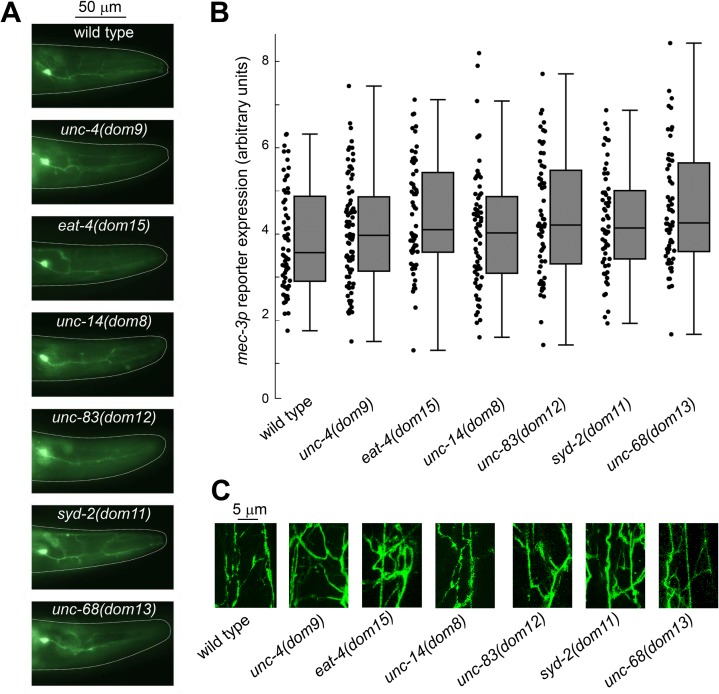
Intact FLP development in unc-4, eat-4, unc-14, unc-83, syd-2, and unc-68 mutants.A: Epifluorescence micrographs of FLP neurons labelled with a mec-3p::cmk-1::mNeonGreen transgene, in wild type and indicated homozygote mutants. B: Quantification of the mec-3p::cmk-1::mNeonGreen reporter expression in FLP cell bodies, showing no difference in the transcription of this FLP differentiation marker between wild type and mutants (one way ANOVA, p>.01). Box plots and individual data points. n≥60 animals. C: Confocal image projections showing the complex FLP neurite arborization in wild type and mutant animals.